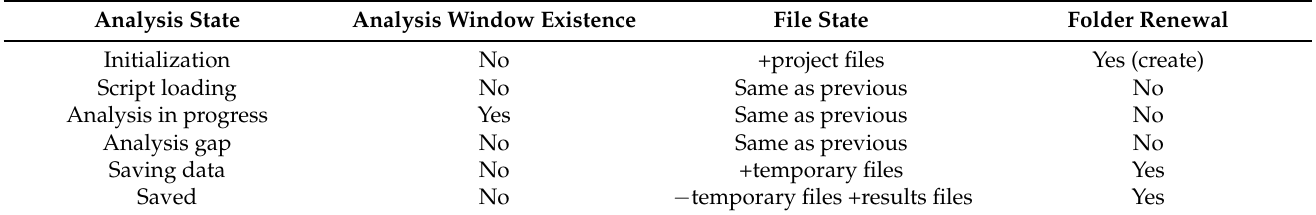
Table 1. Analysis process